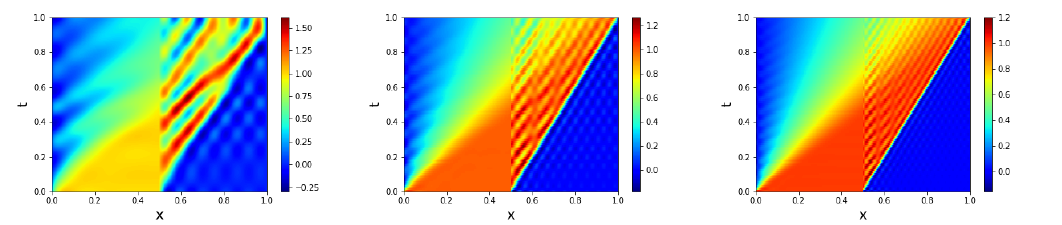
Figure 10. Reconstructive regime, Re = 1000, GP-ROM results: r = 10 ( left ), r = 20 ( middle ), and r = 30 ( right